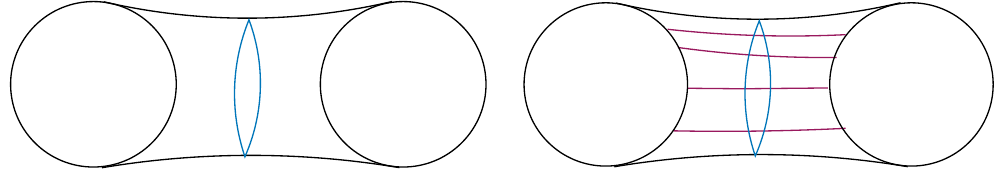
Figure 7 . Directly forming P we can optimize to find the minimal surface and maximal flow. Duality guarantees the flow will saturate on the minimal surface. This is our “optimized